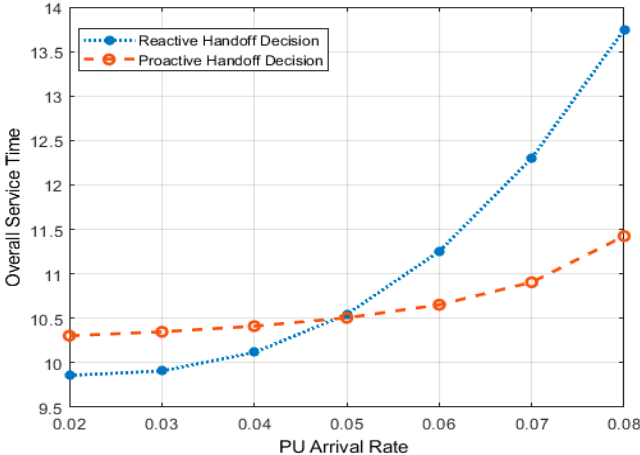
Figure 6. Threshold value detection to toggle among reactive and proactive handoff decisions.